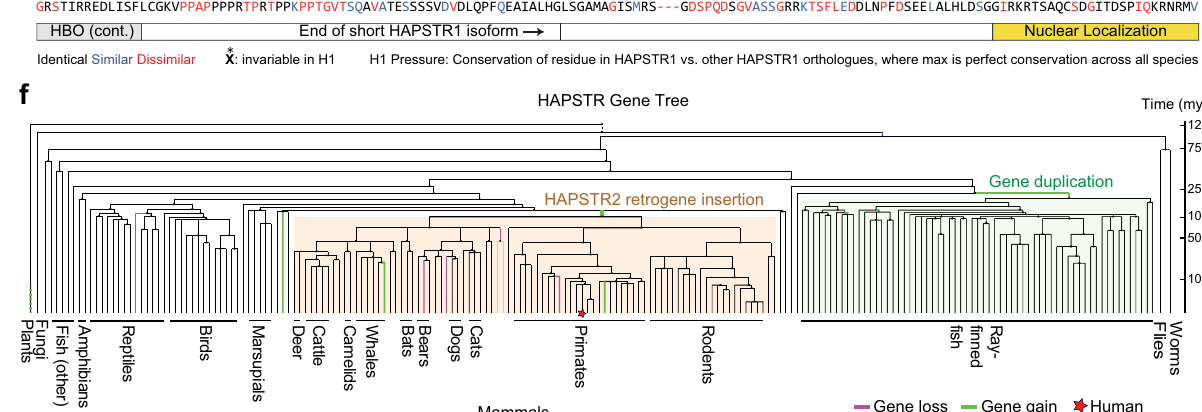
murineorthologs( d ).NotethatdN/dSof1indicatescompleteneutralityandavalue less than 0.5 is a more conservative threshold for functionality when comparing parental gene/retrogene pairs 24,44 . e Comparison of HAPSTR1 with the predicted HAPSTR2 protein. Differences, domains, and degree of conservation for each residue among HAPSTR1 orthologs highlighted; note legend at bottom. Invariable indicatesperfectconservationinallHAPSTR1species. f Tracking HAPSTR genegain and loss events throughout evolution; note legend in bottom right and scale on